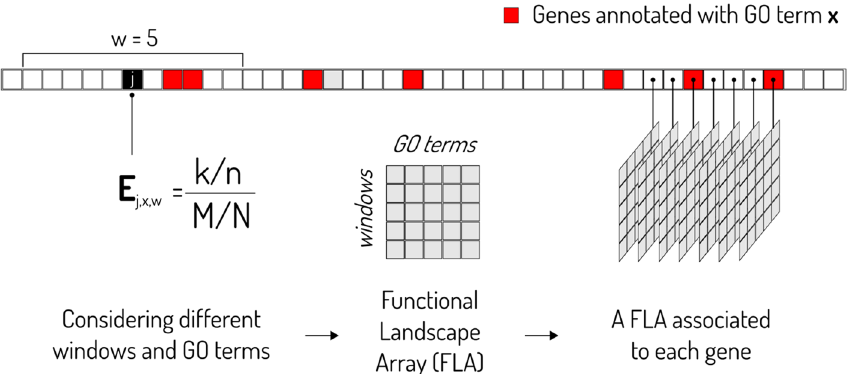
Figure 1. Local enrichment analysis and Functional Landscape Arrays. k is the number of genes in the window associated with GO term x , n is the number of genes in the window, M is the number of genes (squares) in the chromosomal arm (strip) associated with GO term x , and N is the total number of genes in the chromosomal